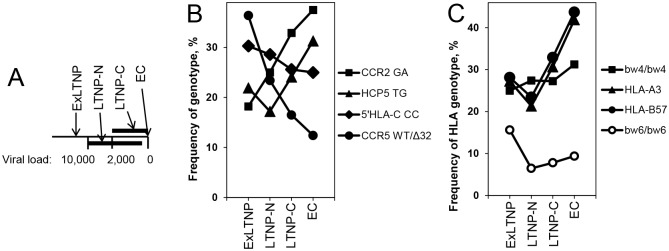
Genotype frequencies among subpopulations of LTNP as a function of viral load.The frequencies of the indicated SNP or CCR5-Δ32 genotypes (B) or HLA genotypes (C) relative to the total number of individuals are plotted for the LTNP subcategories that are graphically depicted (A): ExLTNP, patients who were LTNP for 10 years but thereafter failed to fulfill any of the inclusion criteria; LTNP-N, viremic non controller LTNP, VL>50–10,000; LTNP-C, controllers, VL<2,000 copies/mL; EC, elite controllers, undetectable VL. Displayed are relevant SNP and HLA genotypes with a frequency in the LTNP subcategories above 15%, indicating those that are more frequent (filled symbols) or less frequent (open symbols) in the overall LTNP population than in HD, according to Table 3 and Fig 2.